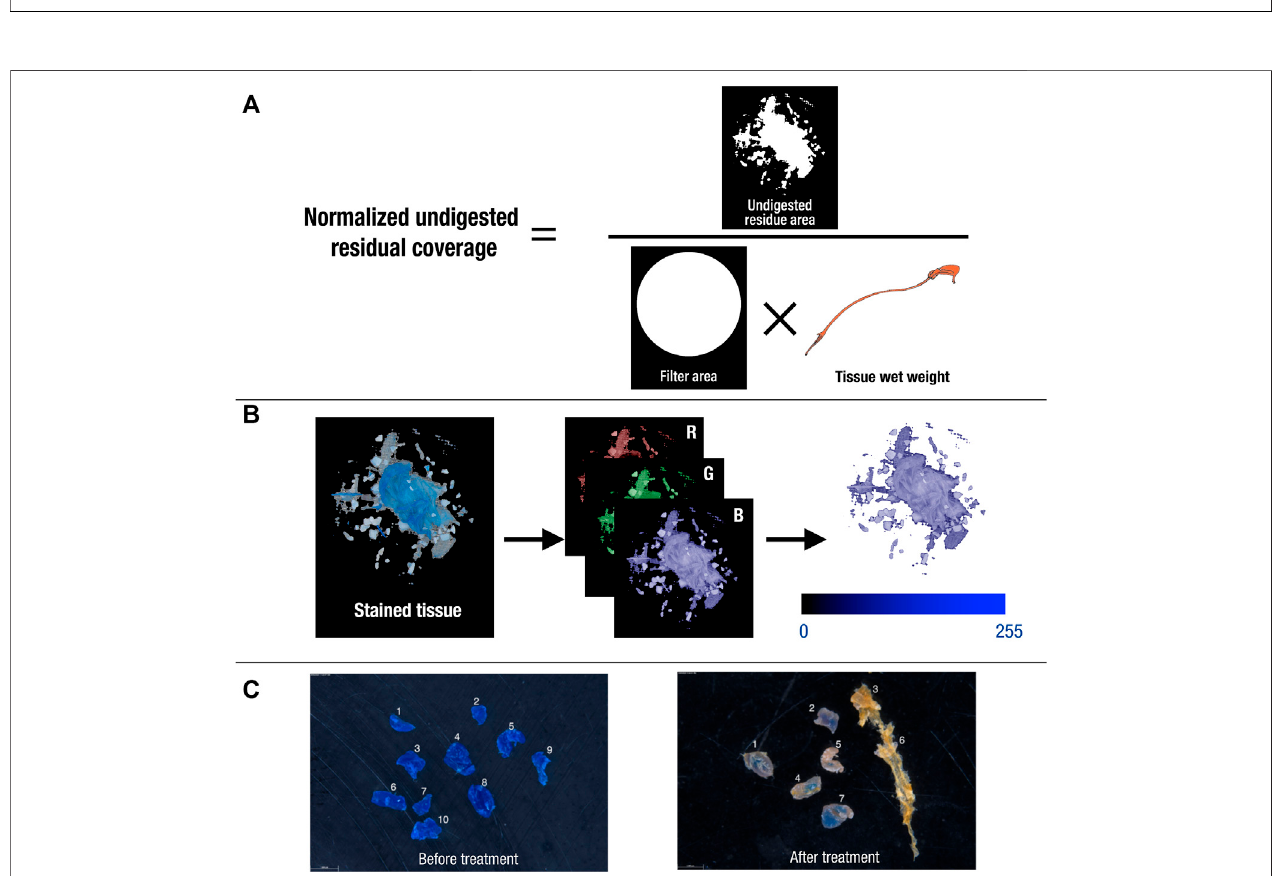
FIGURE4| Illustrationofimageanalysisprotocolfor (A) usingmasksof fi lterandresidueandsampletissuewetweighttocalculate “ normalizedundigestedresidue coverage ” , (B) extracting blue channel from RGB images of stained tissue to calculate “ average blue value ” , and (C) an example of reference polymers (e.g. PE) comparison before and after